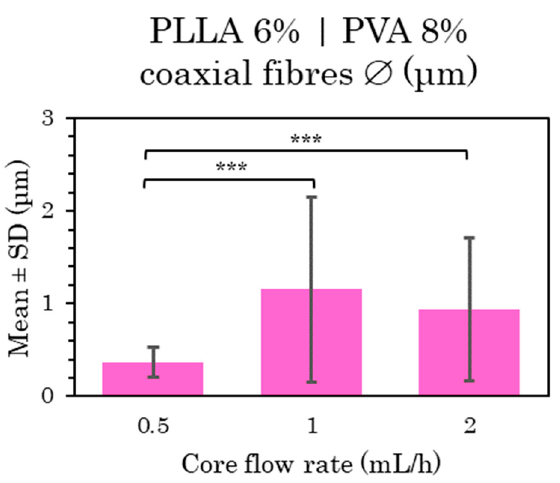
Figure 7. Mean and standard deviation of the diameters of 6% PLLA (shell) and 8% PVA (core) coaxial microfibers manufactured at 0.5, 1 and 2 mL/h, with 15 cm and 15 kV, at (***) p < 0.001 statistically significant di ff erence.